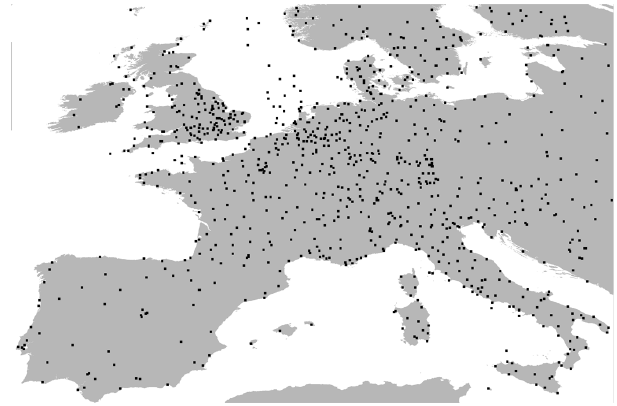
Fig. 1. Positions of the METARs stations used in this